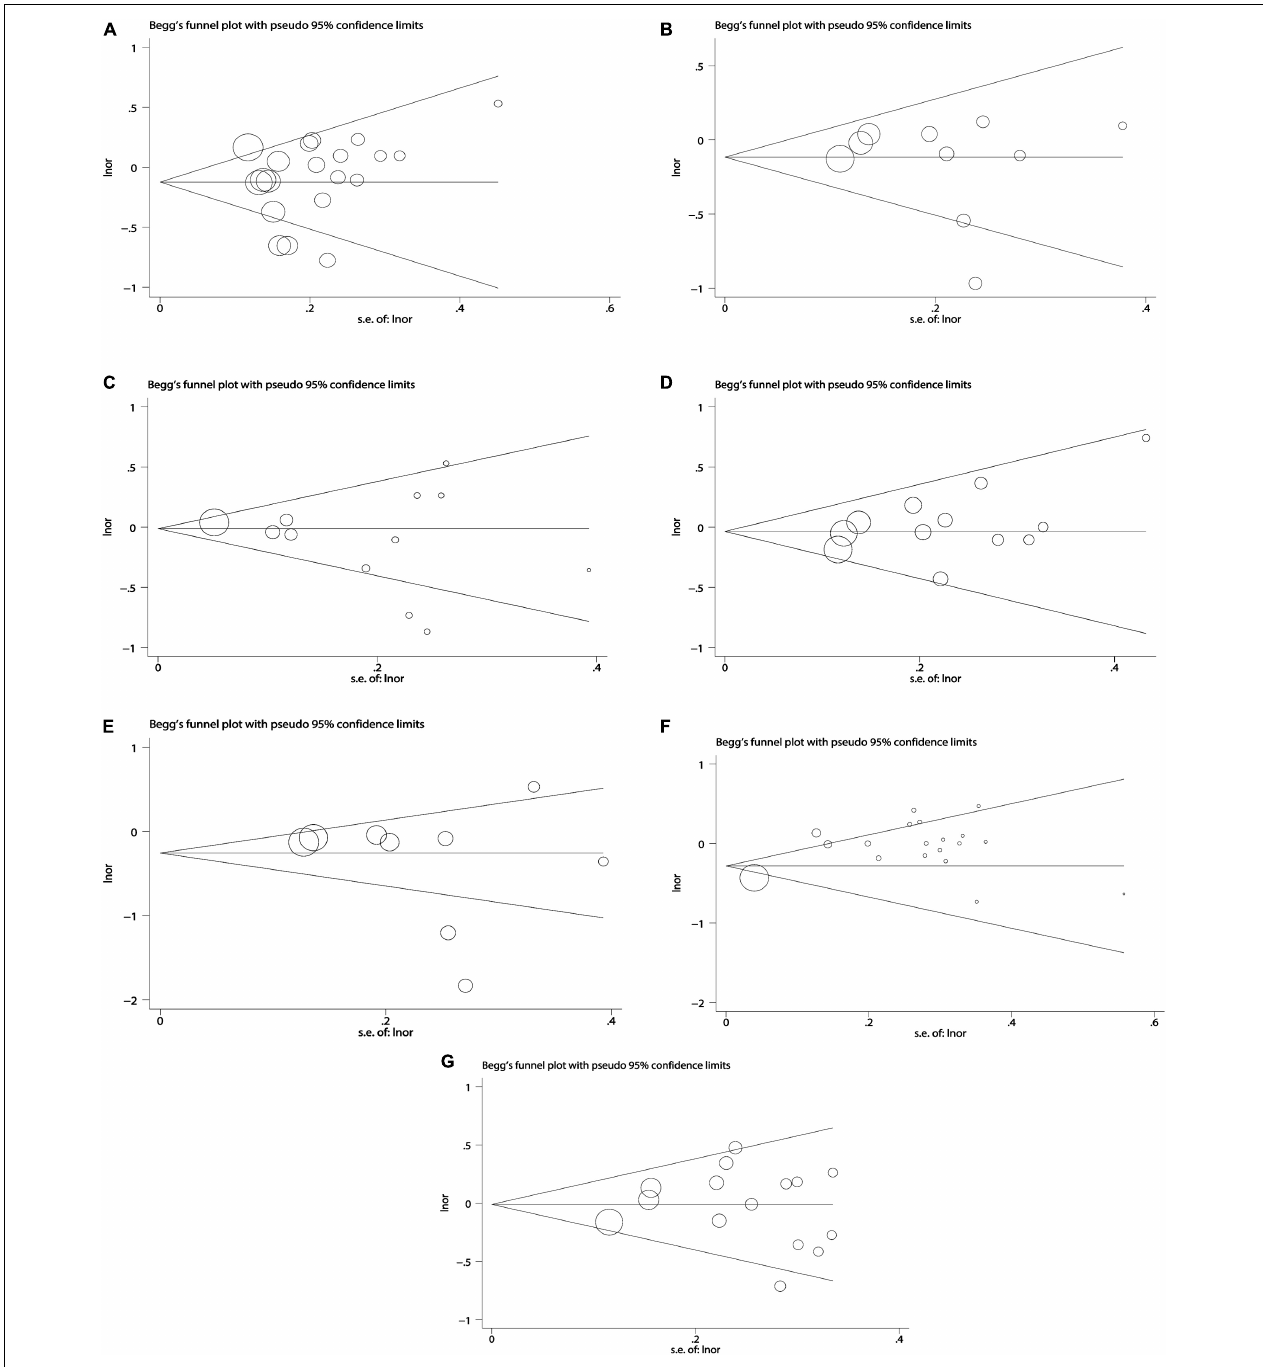
FIGURE 7 | Begg’ s publication bias plots on dietary carotenoids and retinol and colorectal cancer risk. (A) β -carotene; (B) α -carotene; (C) lycopene; (D) lutein/zeaxanthin; (E) β -cryptoxanthin; (F) carotenoids; (G)